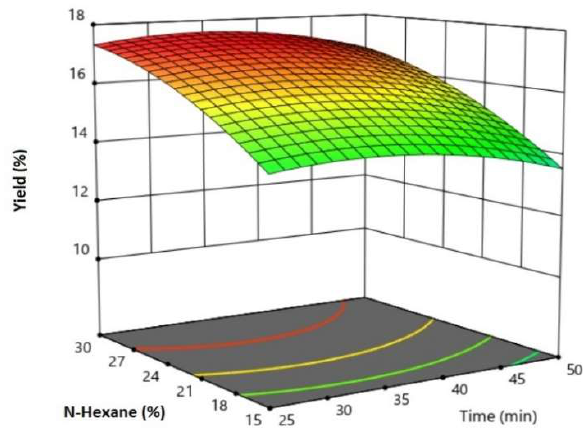
Figure 4. Three-dimensional surface plot of n-hexane vs time.